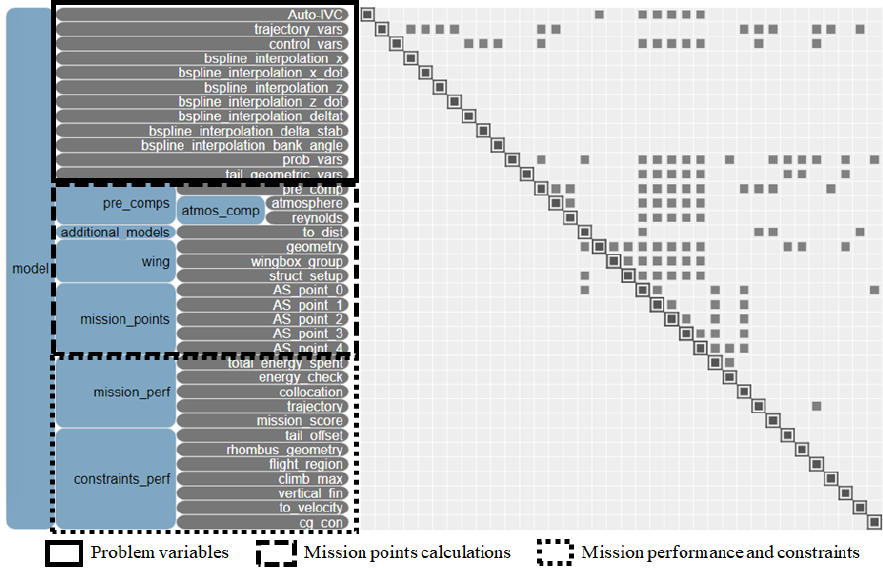
Figure 18. Concurrent design framework N2 diagram